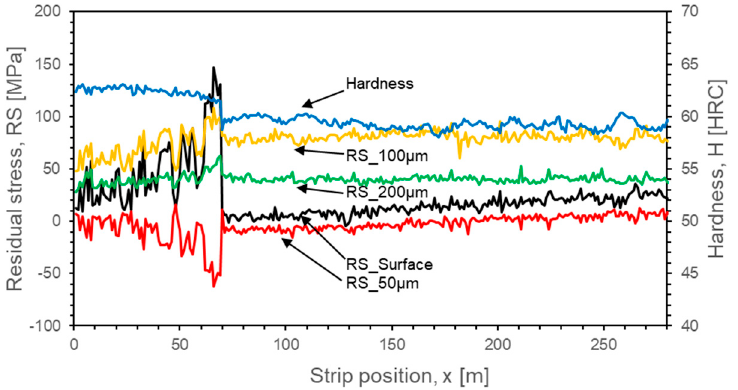
Figure 13. Inline measurement of hardness and residual stress at the surface and at depths of 50, 100, and 200 µ m.